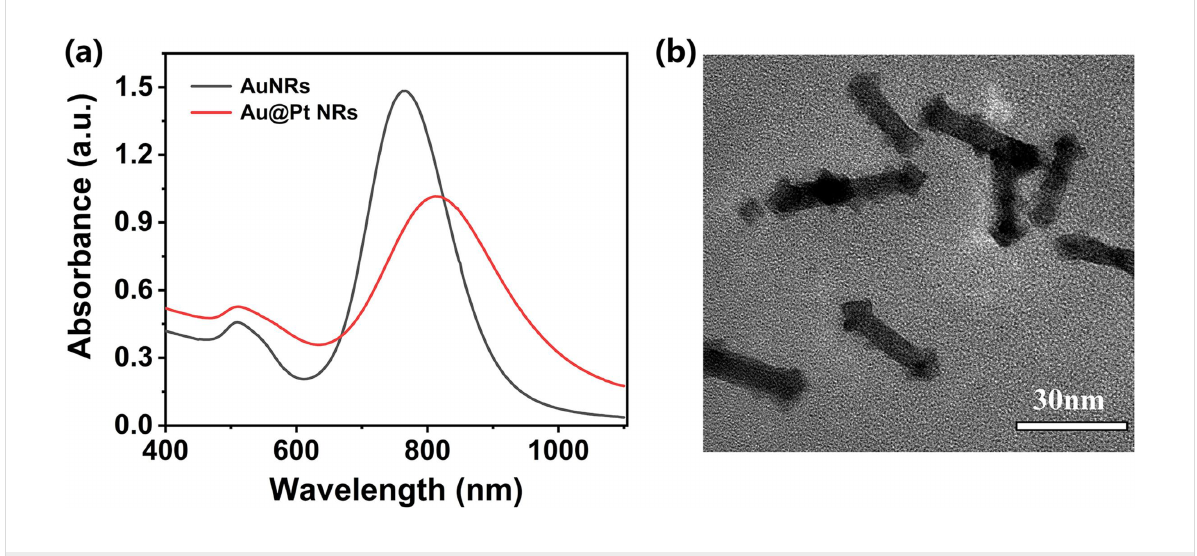
Figure 4: (a) Absorption spectra of AuNRs and of Au@Pt NRs prepared under optimal conditions. (b) TEM image of Au@Pt NRs.